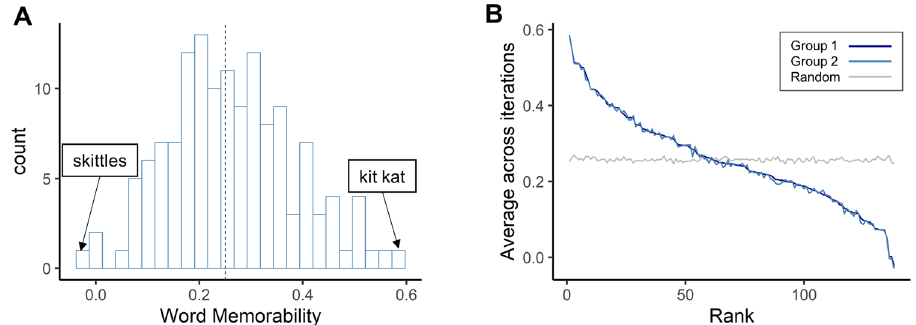
Figure 5. Word memorability scores differ across items but are consistent across participants. ( A ) Distribution of calculated word memorability scores for food items, with examples shown for words with extreme memorability scores. The median of the word memorability scores was 0.25 (dotted vertical line). ( B ) Consistency of word memorability scores in Experiment 2B. The split-half consistency is plotted using ranked average word memorability scores across 1000 iterations of random participant splits. As in Experiment 1A, we plotted the averaged word memorability scores for Group 1 participants (dark blue line) against their rank on the x-axis, scores for Group 2 participants (light blue line), and the scores estimated by random permuted chance (grey line) against the same memorability rank. Group 1 and Group 2 show significant consistency in which words participants remembered and